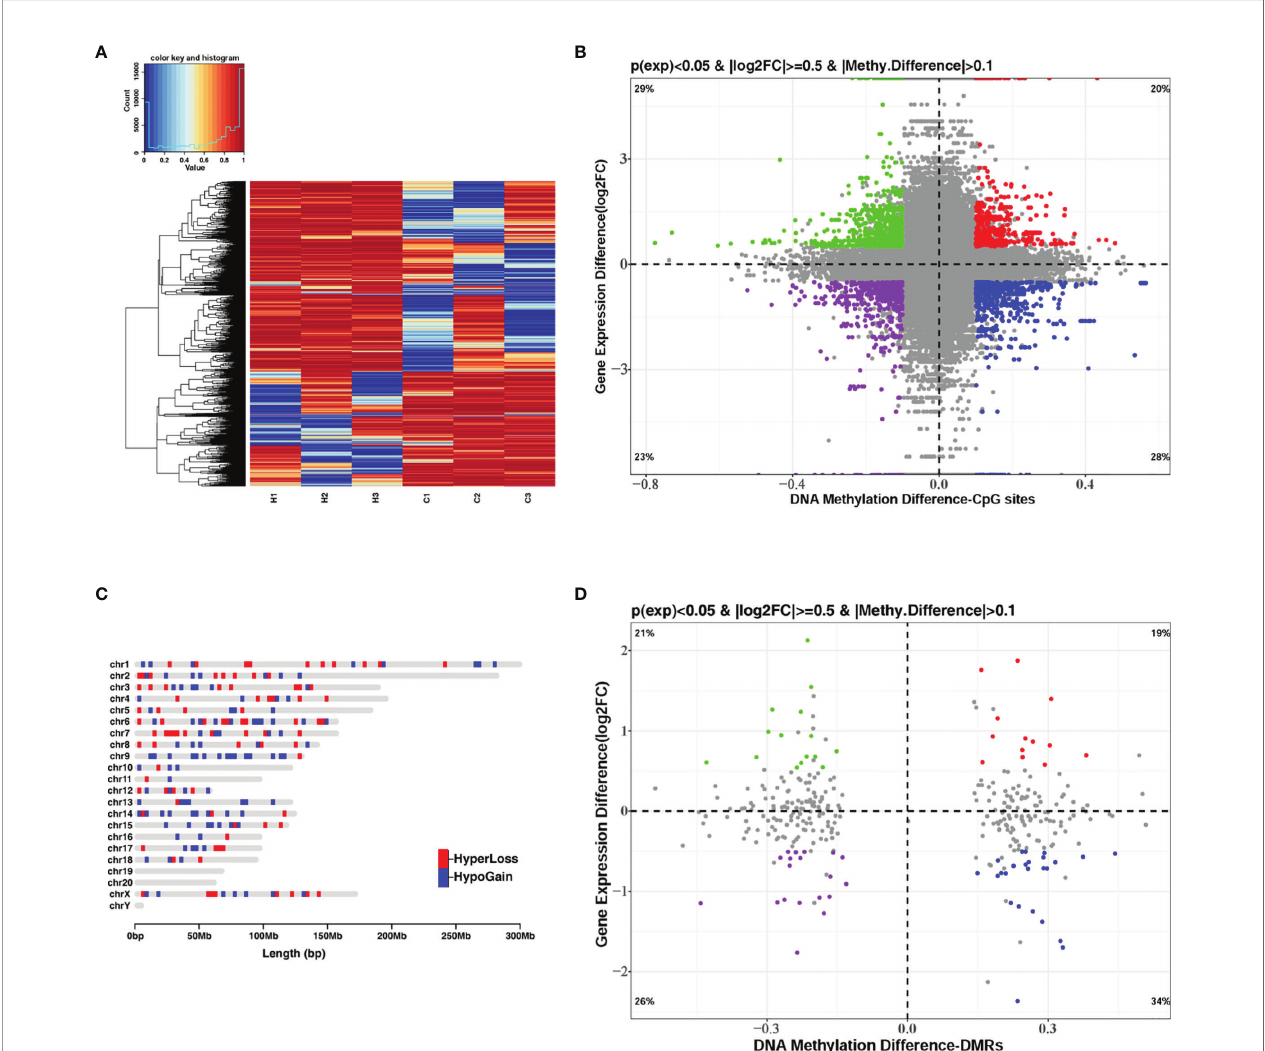
FIGURE 3 | Integrated analysis of DNA methylation and mRNA expression when comparing G. parasuis -infected porcine brain vs. control porcine brain. (A) Hierarchical clustering heatmap of the top-1000 differentially methylated CpG sites from whole-genome bisul fi te sequencing. Each row represents a methylated CpG site, H1, H2, H3 represent G. parasuis -infected porcine brain, and C1, C2, C3 represent negative controls. (B) Scatter plot integrating CpGs methylation and mRNA expression. The vertical axis shows differences in gene expression and the horizontal axis shows differences in DNA methylation for the CpG sites. 1, 3-quadrants represent positive correlated genes, in which gene up-regulation correlates with hypermethylation and gene down-regulation correlates with hypomethylation. The 2, 4-quadrants represent inversely correlated genes, in which gene up-regulation correlates with hypomethylation and gene down-regulation correlates with hypermethylation. (C) Karyogram showing genome-wide coverage of differentially methylated sites that inversely correlate to gene expression (2, 4-quadrants in B). Hypermethylated sites correlated with gene down-regulation are shown in red (HyperLoss). Hypomethylated sites correlated with gene up-regulation are shown in blue (HypoGain). (D) Scatter plot integrating DMRs and mRNA expression. The vertical axis shows differences in gene expression and the horizontal axis shows differences in DNA methylation of DMRs. The 1, 3- quadrants represent positively correlated genes and the 2, 4-quadrants represent inversely correlated